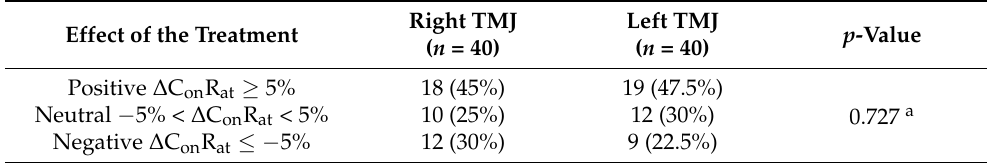
Table 9. The results of the treatment assessed on the basis of the of the condylar ratio changes in the study group.